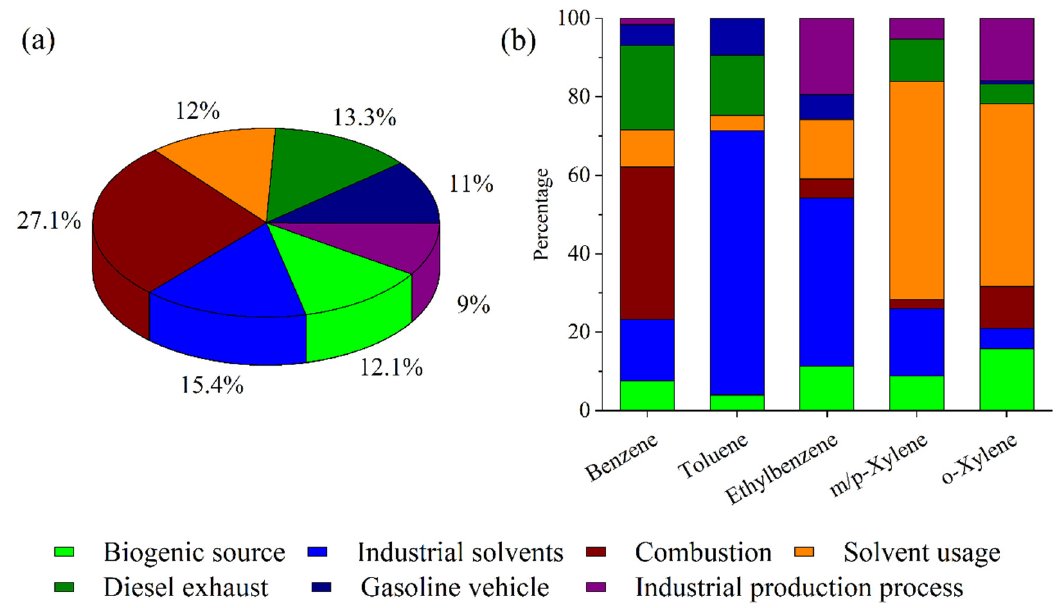
Figure 6. The contribution of emission sources ( a ) and the contribution of BTEX in different emission sources ( b ).